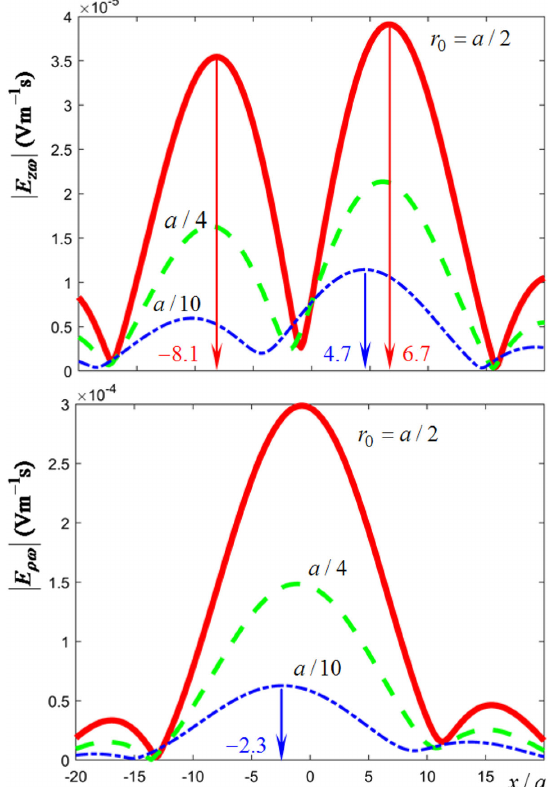
FIG. 5. Dependence of absolute values of longitudinal ( E and transverse ( E ρω ) field over x for y ¼ z ¼ 0 for three values of charge ’ s shift r 0 ¼ a= 10 ; a= 4 ; a= 2 . Calculation parameters are the same as in Fig.